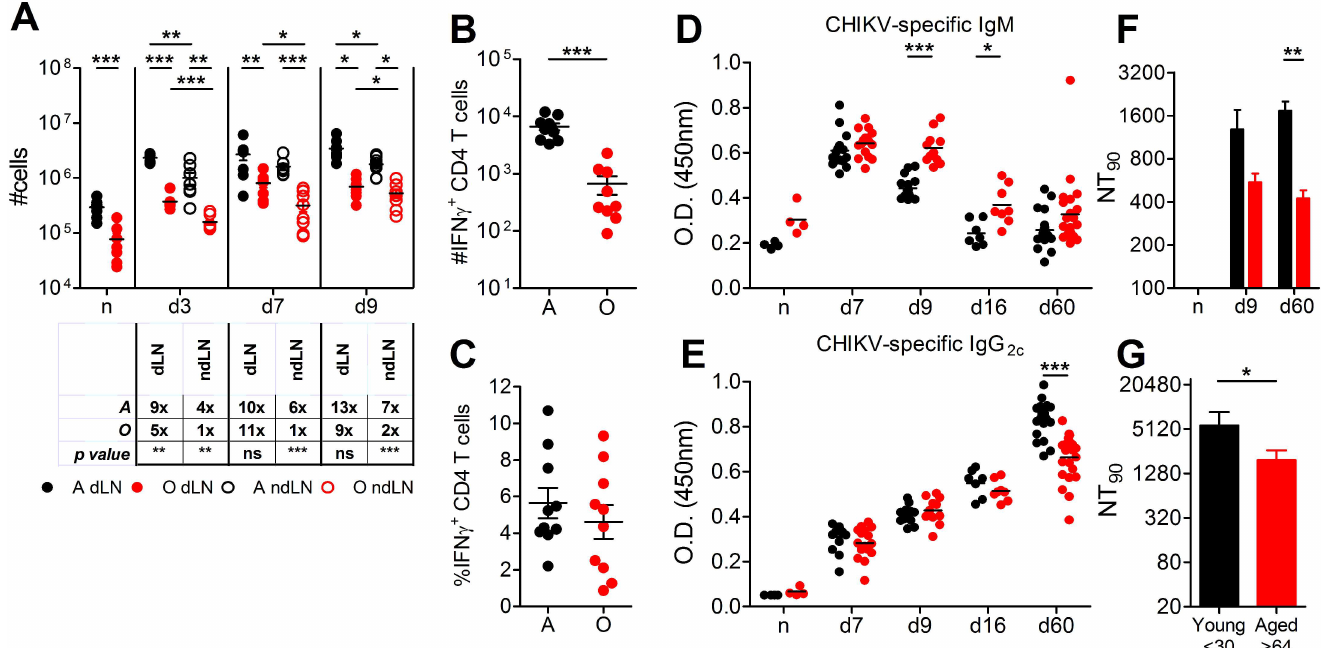
Fig 3. Age-related impairment of adaptive immune response to CHIKV. (A) Popliteal LNs collected and quantifiedfrom either na ï ve or CHIKV- infected A and O mice at day 3, 7, or 9 post-infection. The LN drainingfrom the CHIKV-inoculated foot is indicatedas dLN and from the non-inoculated foot as ndLN. Table under graph indicatesthe average fold-increase from na ï ve for each age in either the dLN or ndLN ( n = 6–8 per group). Horizontal lines indicate the median. Statistical significancedetermined by student’s t -test. (B-C) Lymphocytes from poplitealLNs on d7 post-infection were stimulated with CHIKV peptides in the presence of protein transport inhibitor. Total number of IFN γ + CD4 T cells (B) and frequency (C) for each age. Data are mean ± SEM ( n = 10 per group). Statistical significance determinedby unpairedStudent’s t -test. (D) CHIKV-specific IgM and (E) IgG2c in serum determinedby ELISA at the indicatedday post-infection. Data are mean ( n = 4–24 per group). Statistical significance was determinedby two-way ANOVA with Bonferroni post-test. (F) Plaque reduction neutralizing test on serum from days 9 and 60 post-infection. Data are mean + SEM ( n = 12 per group). Statistical significance was determinedby two-way ANOVA with Bonferroni post-test. (G) Serum samples collected from patients experiencing acute CHIKV-disease were evaluated by plaquereduction neutralizingtest. Data are mean + SEM ( n = 24 young and 15 aged). Statistical significance was evaluatedby unpairedstudent’s t -test. In all panels black indicates A, red indicates O; * P < 0.05; ** P < 0.01; *** P < 0.001.